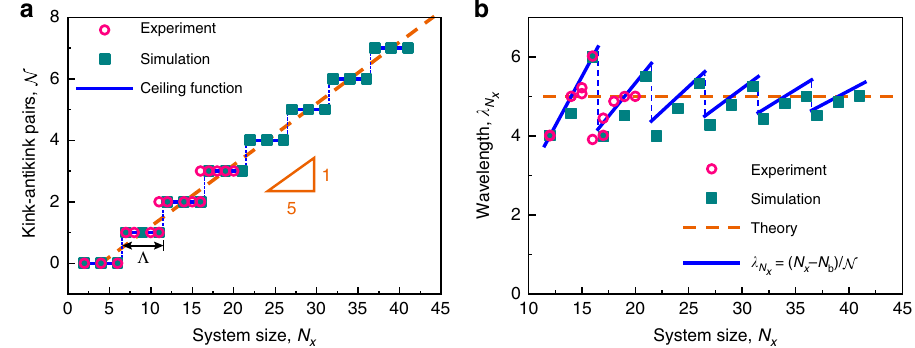
Fig. 4 Size dependence of kink-antikink pairs and the soliton wavelength. a Number of kink-antikink pairs as a ceiling function of the system size. The step length is equal to the theoretical period T . The characteristic length to permit a stable kink-antikink pair is N dependence arises. b Wavelength versus system size in experiments and simulations. The simulated behavior of a fi nite system gradually approaches that of the continuous model. Fitting the simulated data by λ N